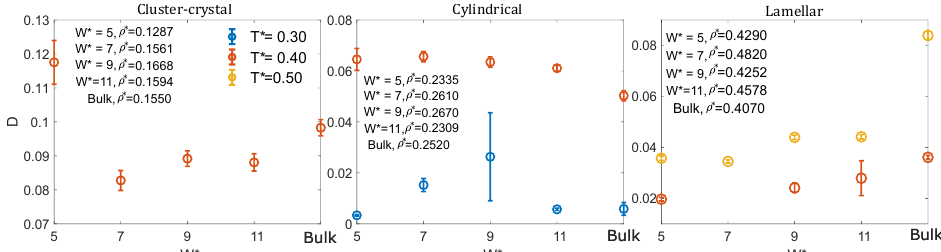
Figure 8. Diffusion coefficient as a function of pore width, for low ( left panel), medium ( middle panel) and high ( right panel) densities, at temperatures around those at which the periodic mi- crophases start to spontaneously